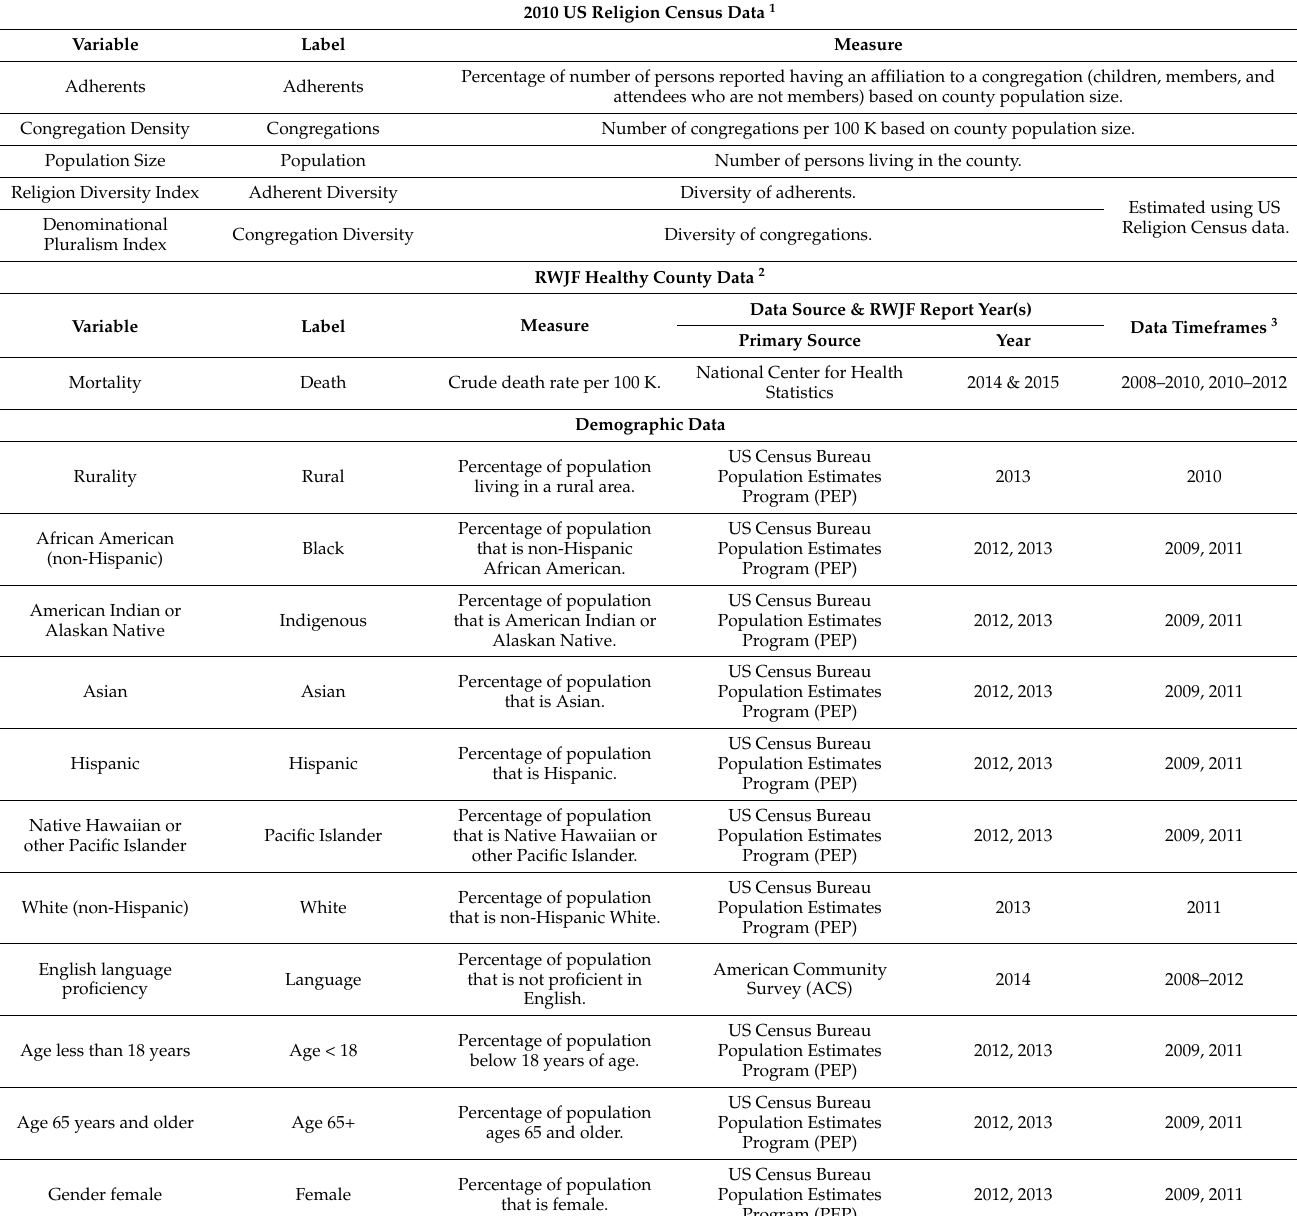
Table A1. Data Definitions, Sources, and Data Timeframes (note to self: add more footnotes for special